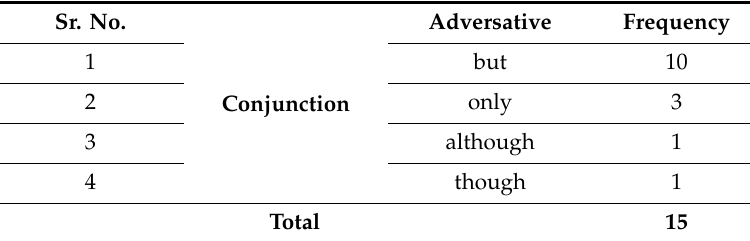
Table 6. Adversative